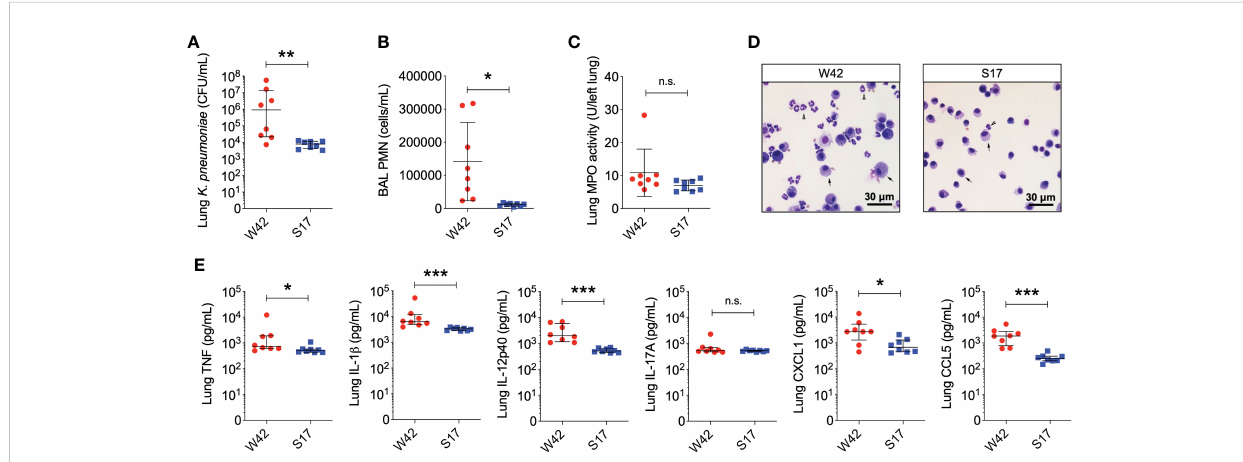
FIGURE 3 Mice infected with the phagocytosis-sensitive Kp isolate S17 display lower bacterial burden accompanied by reduced in fl ammation compared to mice infected with the phagocytosis-resistant isolate W42. (A) CFU of Kp in lung homogenates obtained from C57BL/6J mice 48 hours following intratracheal infection with W42 Phago-Res (N=8) or S17 Phago-Sens (N=8, inoculum: 10 3 CFU). (B) PMN numbers in BAL specimens from mice infected with W42 and S17. (C) MPO activity in lung tissue homogenates from W42- and S17-infected mice. (D) Representative images of cytospin preparations of BAL specimens from W42- and S17-infected mice stained with a differential stain. Arrow-heads represent PMN, arrows represent mononuclear phagocytes. (E) Levels of TNF, IL-1 b , IL-12p40, IL-17A, CXCL1, and CCL5 in lung tissue homogenates from W42- and S17-infected mice as determined by ELISA. Data represent medians ± interquartile range (A, E) or means ± SD (B, C) + individual data points. *p<0.05, **p<0.01, ***p<0.001, n.s.: not signi fi cant (A, E) : Mann-Whitney test; (B, C) : t test with Welch ’ s